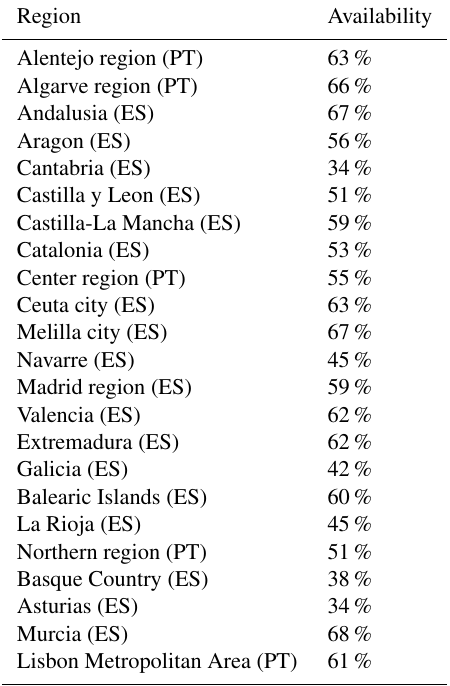
Table G1. Mean data availability of TROPOMI TrC-NO 2 over the different regions of the Iberian Peninsula, on average over 2018–2021.